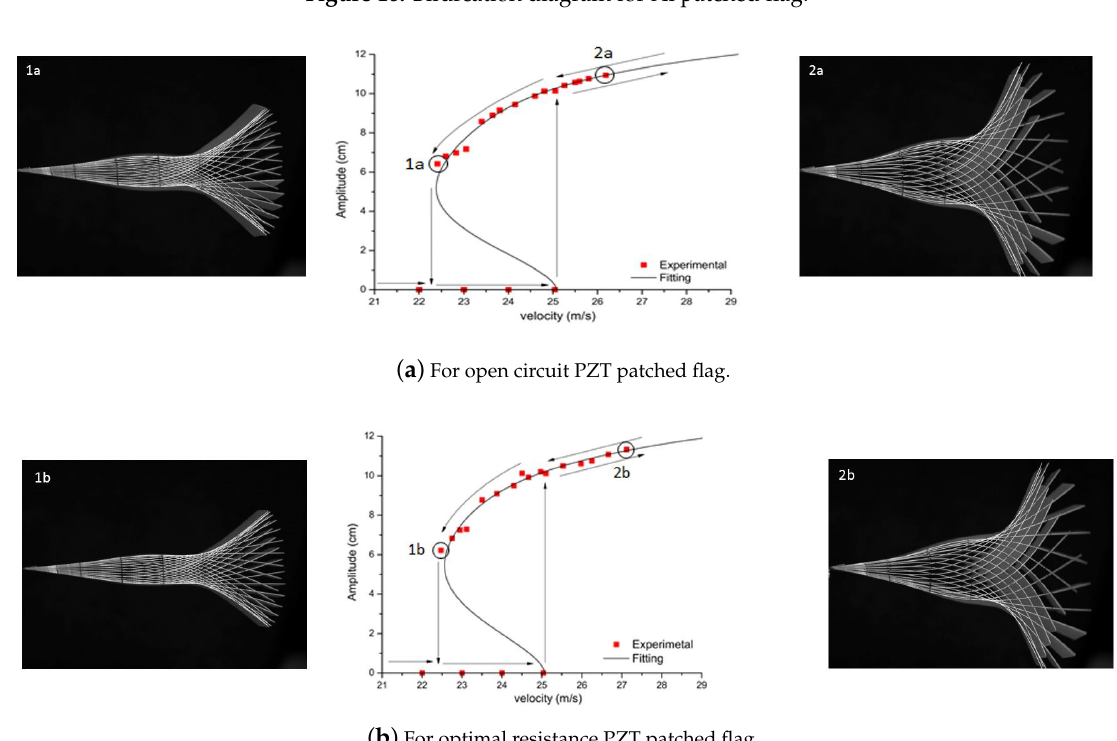
( b ) For optimal resistance PZT patched flag. Figure 11. Bifurcation diagram for PZT patched